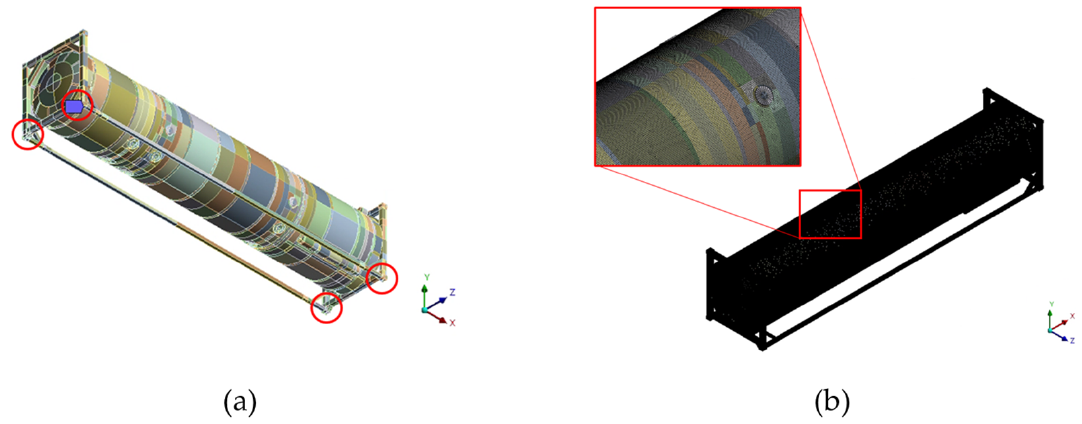
Figure 3. ( a ) Constrained positions of the computational domain. ( b ) Computational mesh.